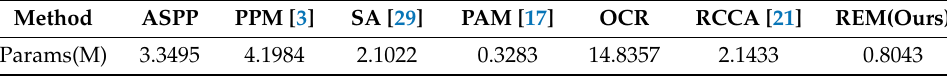
Table 4. Comparison with other similar work in terms of the number of parameters.